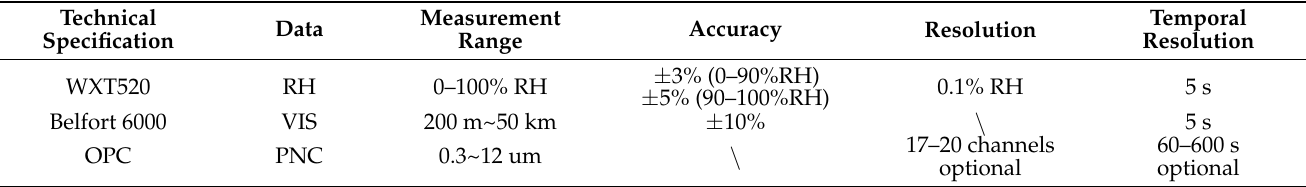
Table 1. Technical specifications and temporal resolutions of measurement